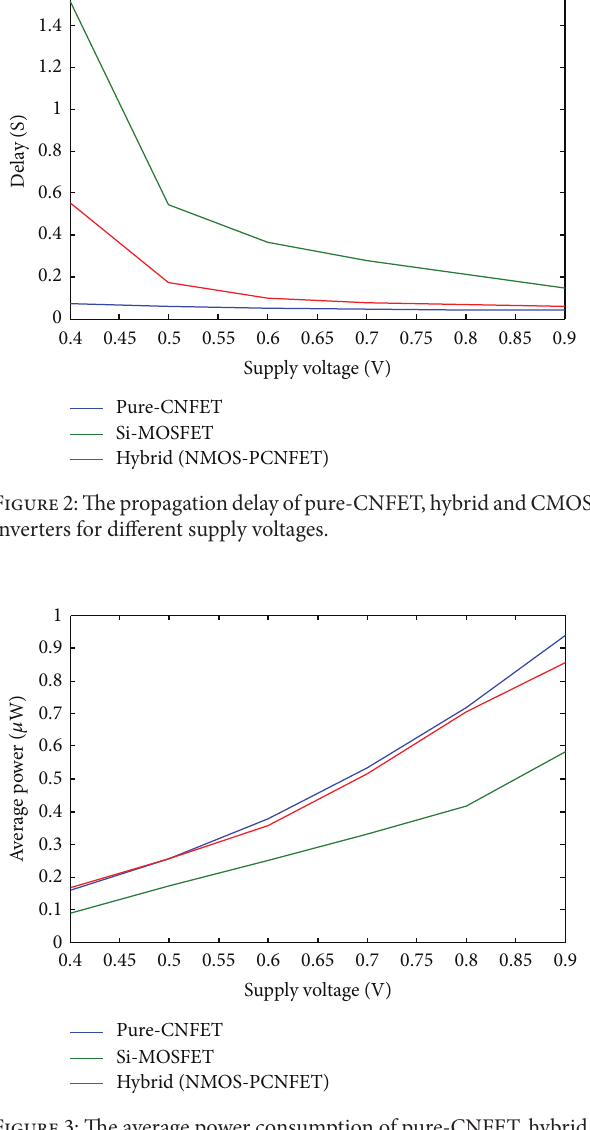
Figure 3: The average power consumption of pure-CNFET, hybrid, and CMOS inverter for different supply voltages.